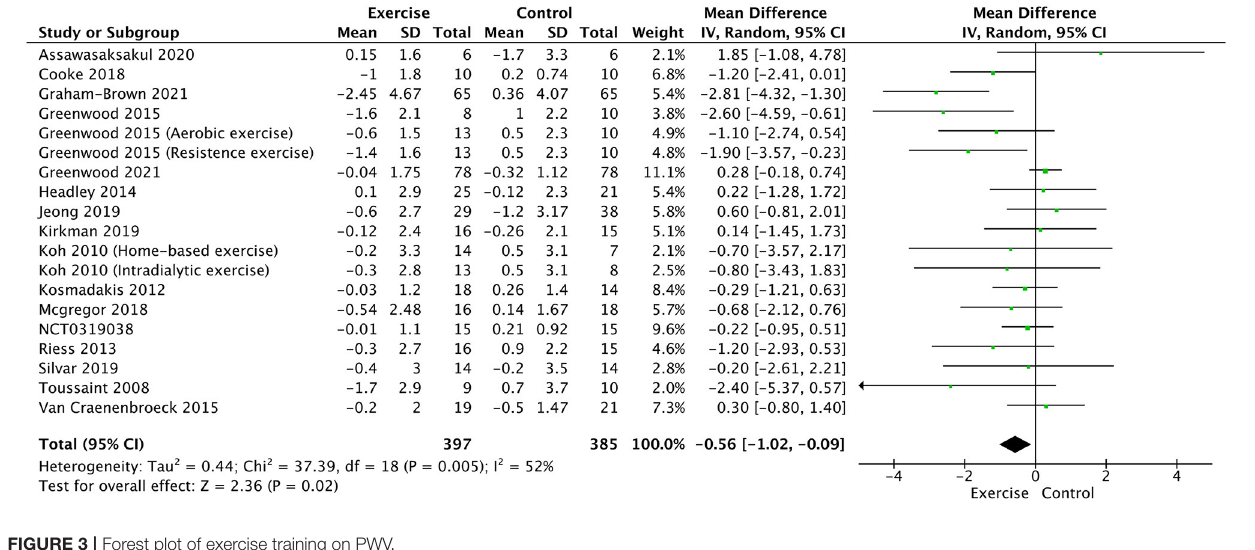
FIGURE 3 | Forest plot of exercise training on PWV.